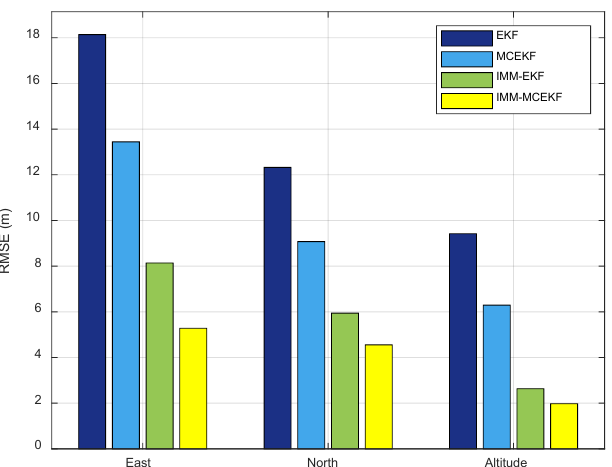
Figure 10. Comparison between the pdfs of three-dimensional position errors for the four approaches: ( a ) east; ( b ) north; and ( c ) altitude.